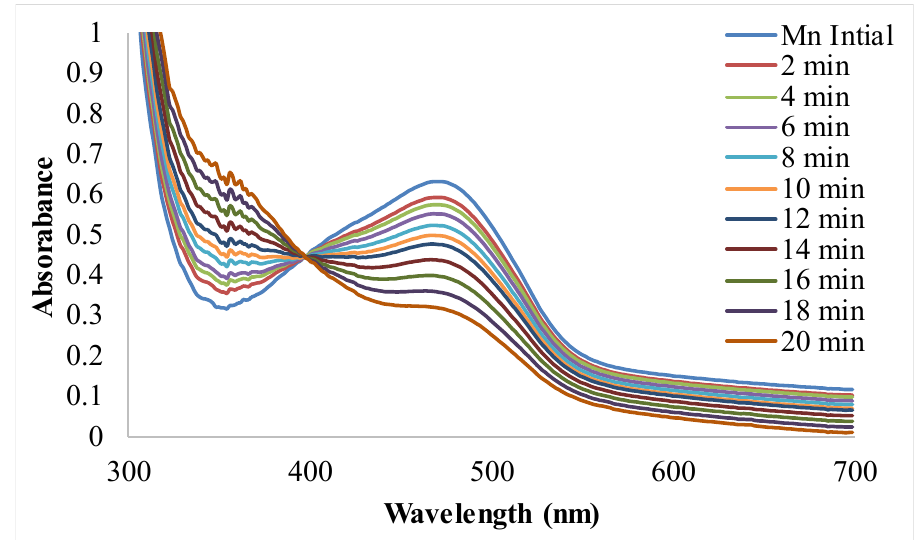
Figure 8. UV-visible spectra for photocatalytic degradation of MO using Mn NPs. Green synthesized Fe-Mn BmNPs were evaluated for their photocatalytic degradation of MO dye. For this purpose, same optimized conditions were used as that for Fe and Mn NPs. Bimetallic nanoparticles exhibited excellent efficiency for the degradation of MO.